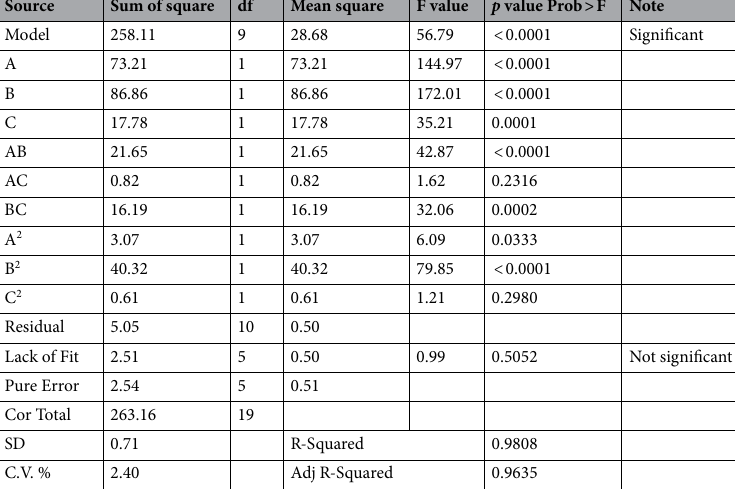
Table 8. Analysis of variance (ANOVA) and results of regression analysis of the CCD on ethanol production from PWH using S. cerevisiae